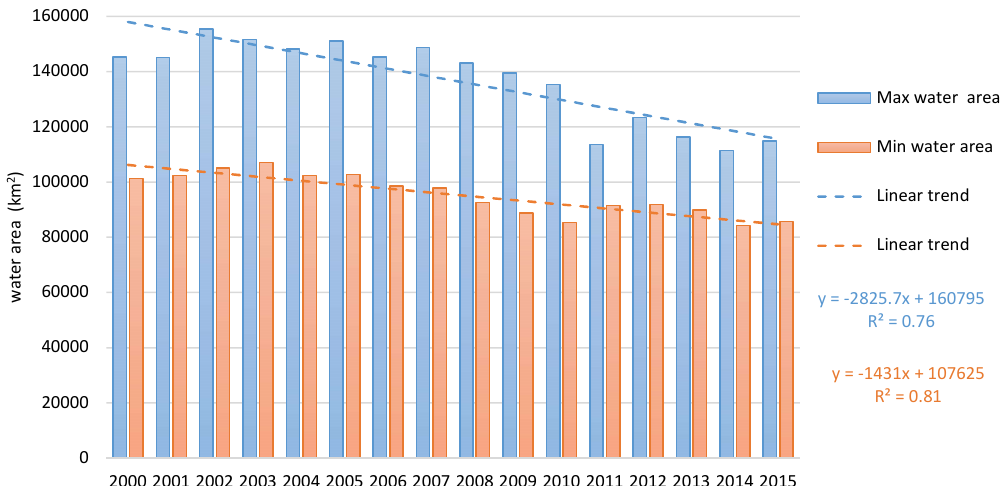
Figure 8. Changes to the maximum and minimum intra-annual water area from 2000 to 2015 in arid and semi-arid regions of central Asia.